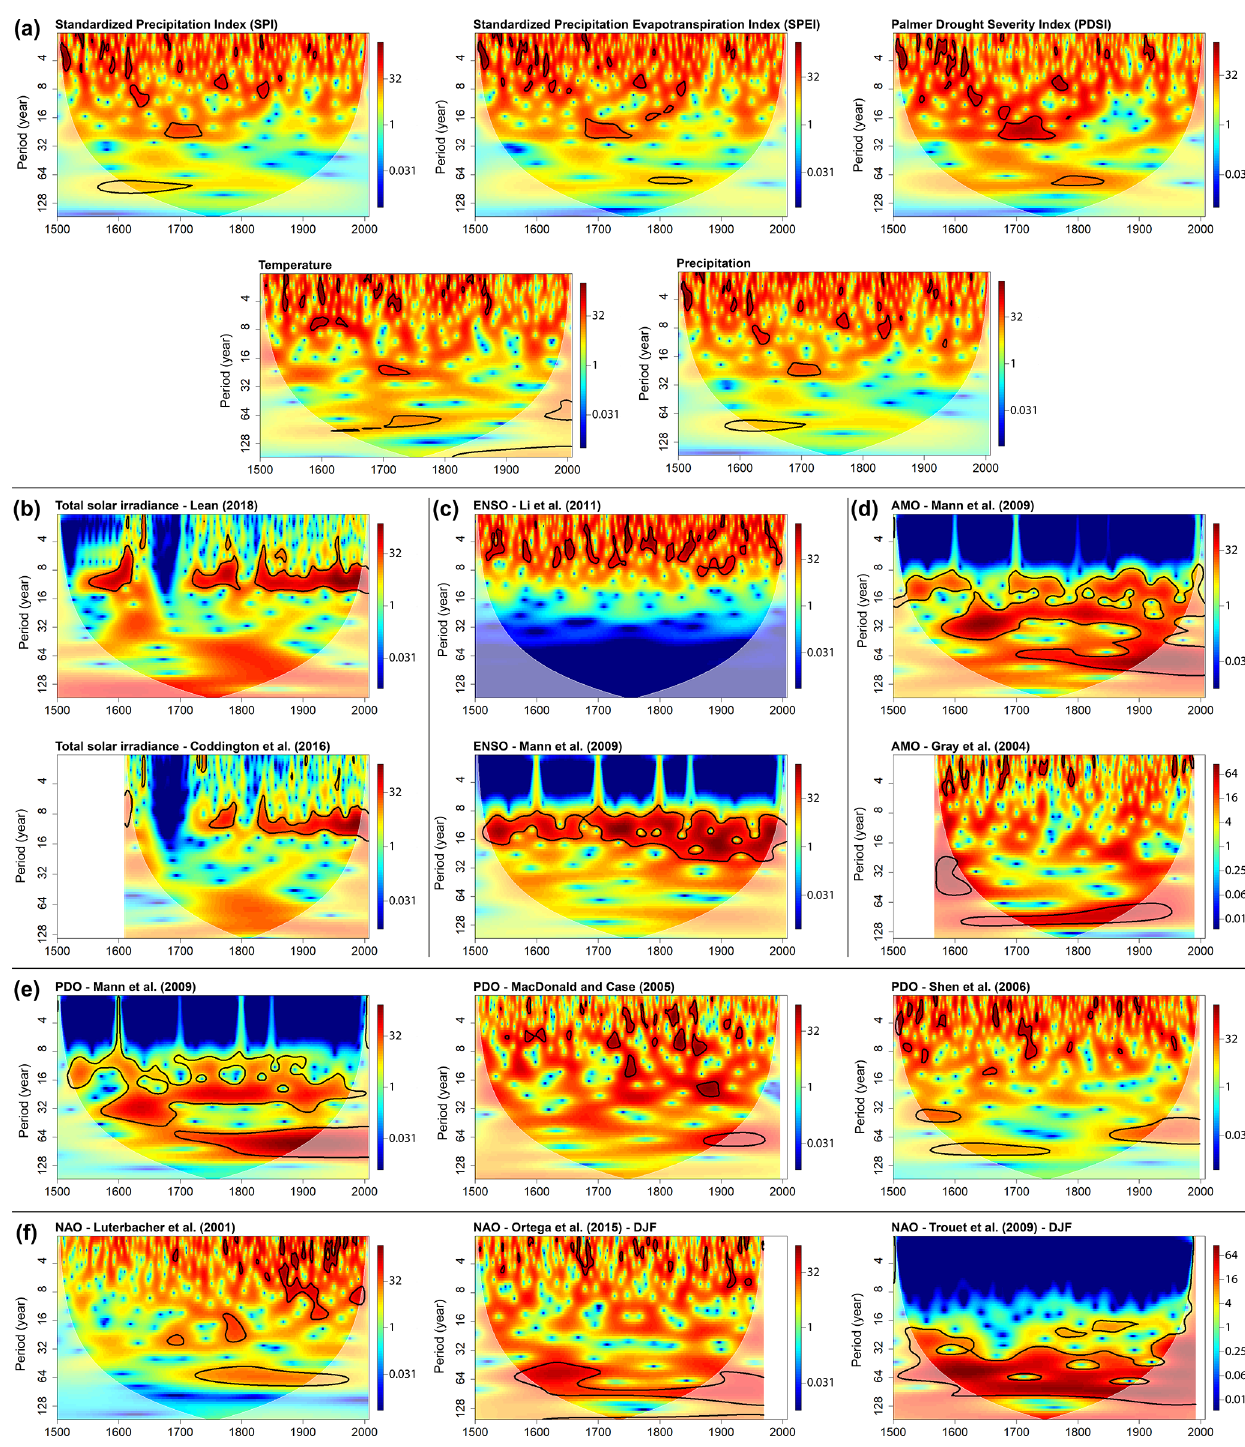
Figure 7. Standardized wavelet power spectra of annual series of (a) Czech drought indices, temperature and precipitation, as well as of individual explanatory variables with prominent oscillatory component: (b) total solar irradiance, (c) ENSO, (d) AMO, (e) PDO and (f) NAO. Areas enclosed by a black line correspond to wavelet coefficients statistically significant at the 95% level, AR(1) process null hypothesis. The lower-contrast areas pertain to the cone of influence, i.e., a region with diminished representativeness of the wavelet spectra due to edge